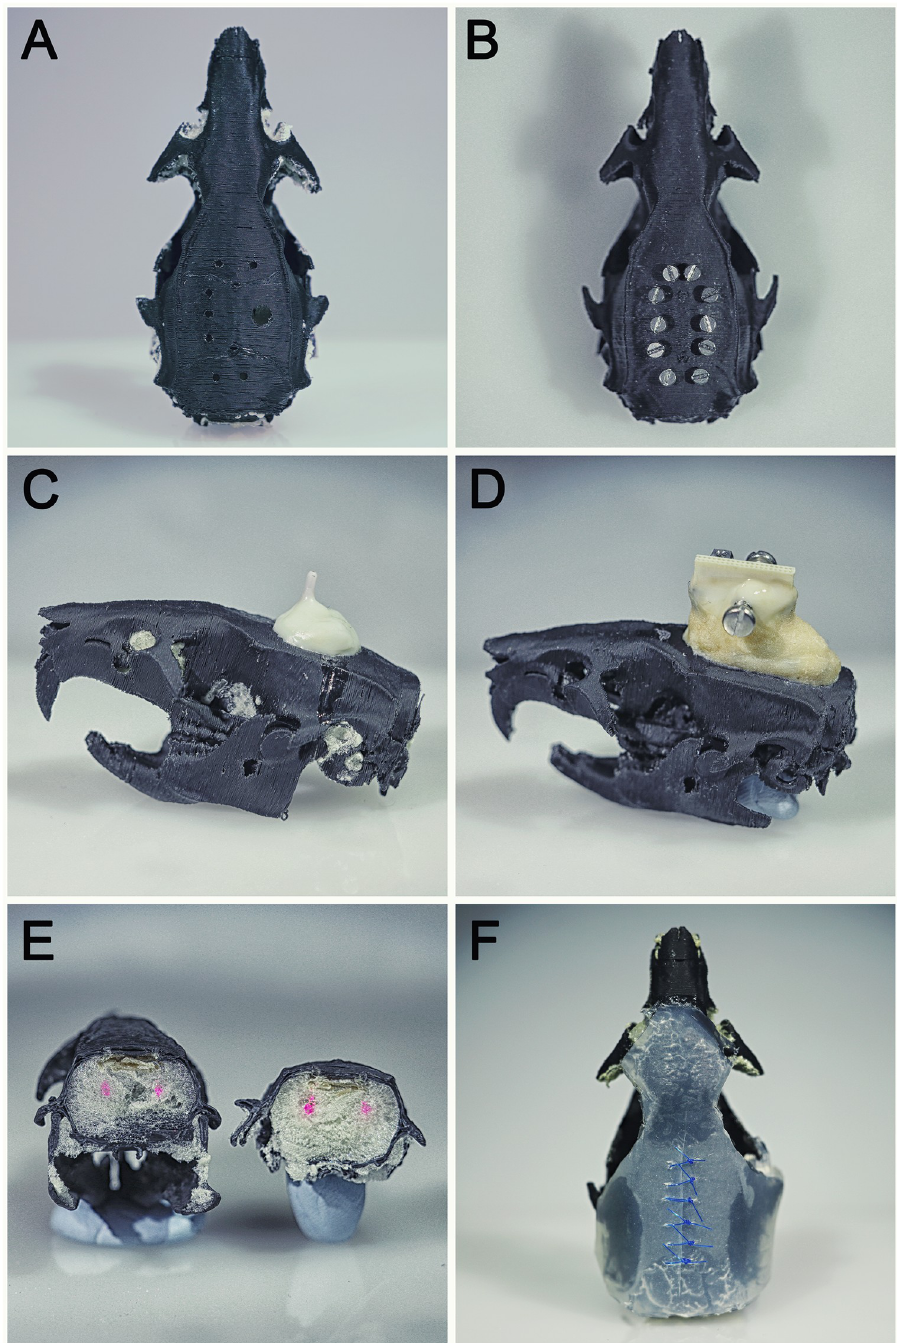
Fig 6. Different techniques that can be learned and practiced using the skin-skull-brain model. (A) Craniotomies. (B) Screws placement. (C) Optic fiber implantation and securing using bone/dental cement. (D) Large Electrophysiology probes implantation and securing using bone/dental cement. (E) Brain injections. (F) Suturing.